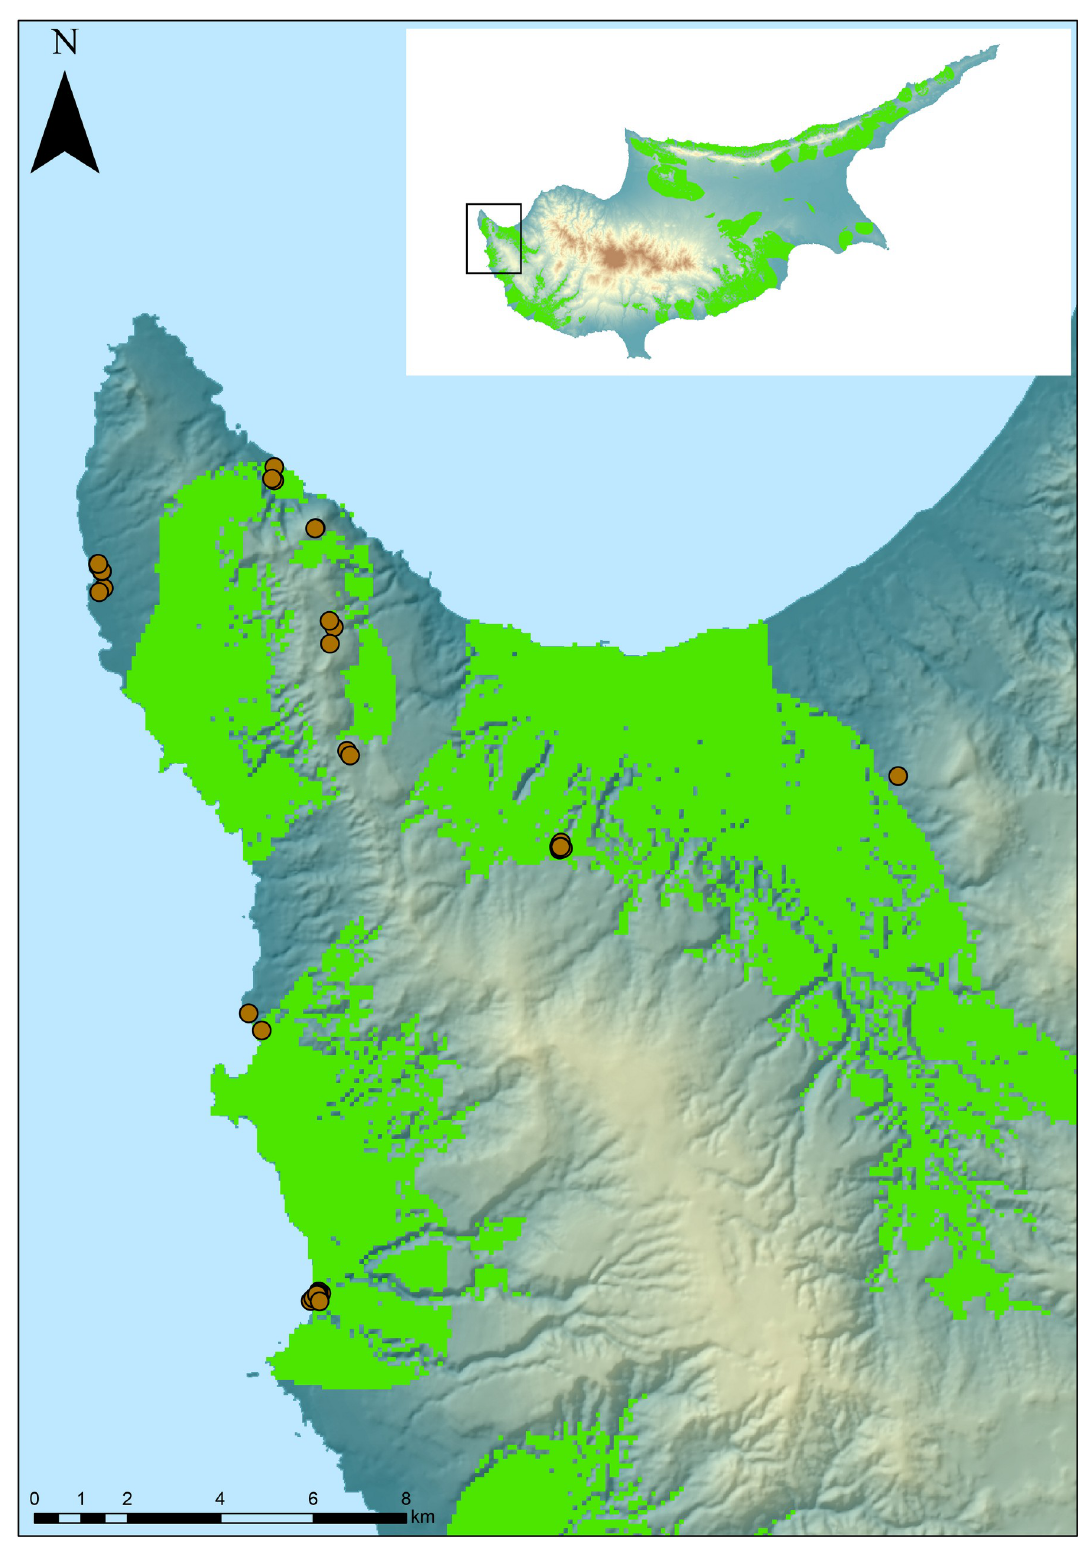
Fig 8. Archaeological localities identified during field surveys based on the predictive model outcomes. Archaeological localities identified during field surveys superimposed over predictive map (green area). Insert shows the location of surveyed region on the island of Cyprus. Original copyright with the